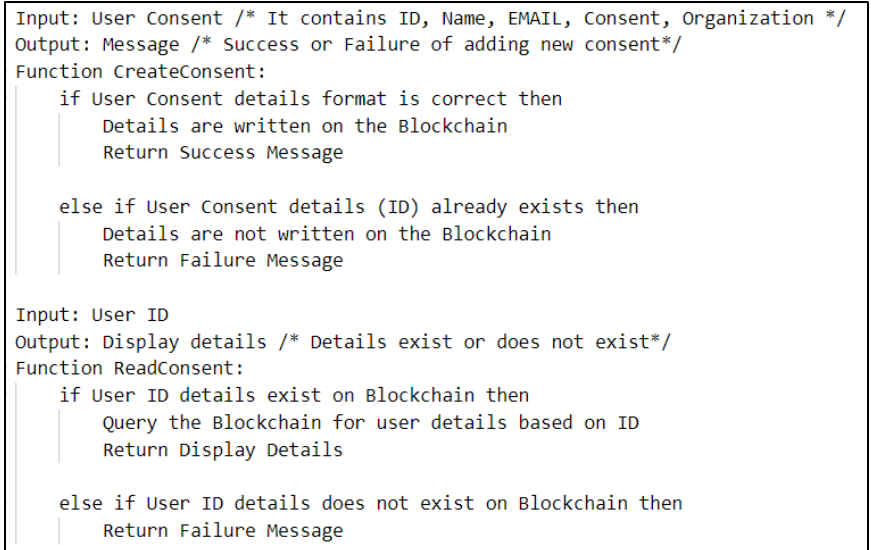
Figure 3. Pseudocode of the chaincode.